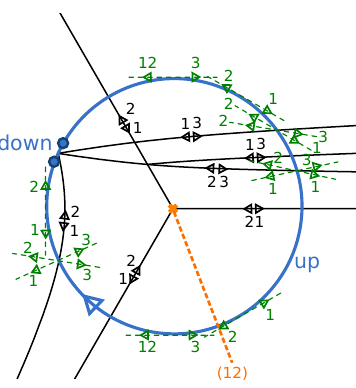
Figure 39 . An unknot L ⊂ M = R 3 . The x 3 -coordinate increases as we traverse the loop, except for a very small region where it decreases. We show, in black, all ij -leaves which participate in BPS webs: this includes in particular the three critical leaves emerging from the branch point at z = 0 . We also show, in green, the directions of ij -leaves at tangencies to L or its lifts; these are used in the computations of tangency and winding factors.